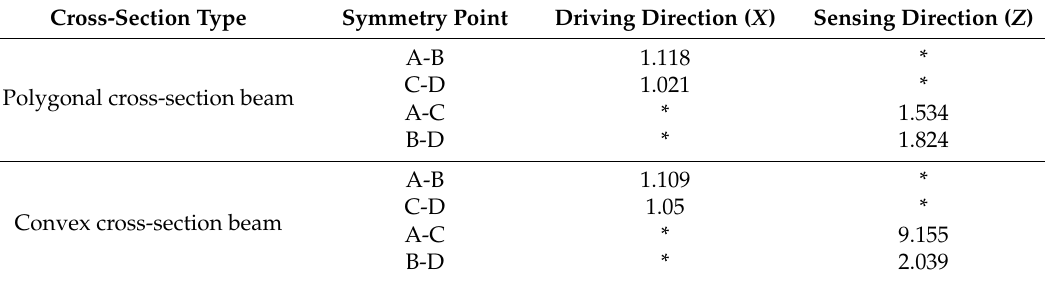
Table 5. The symmetry of displacement change (unit: